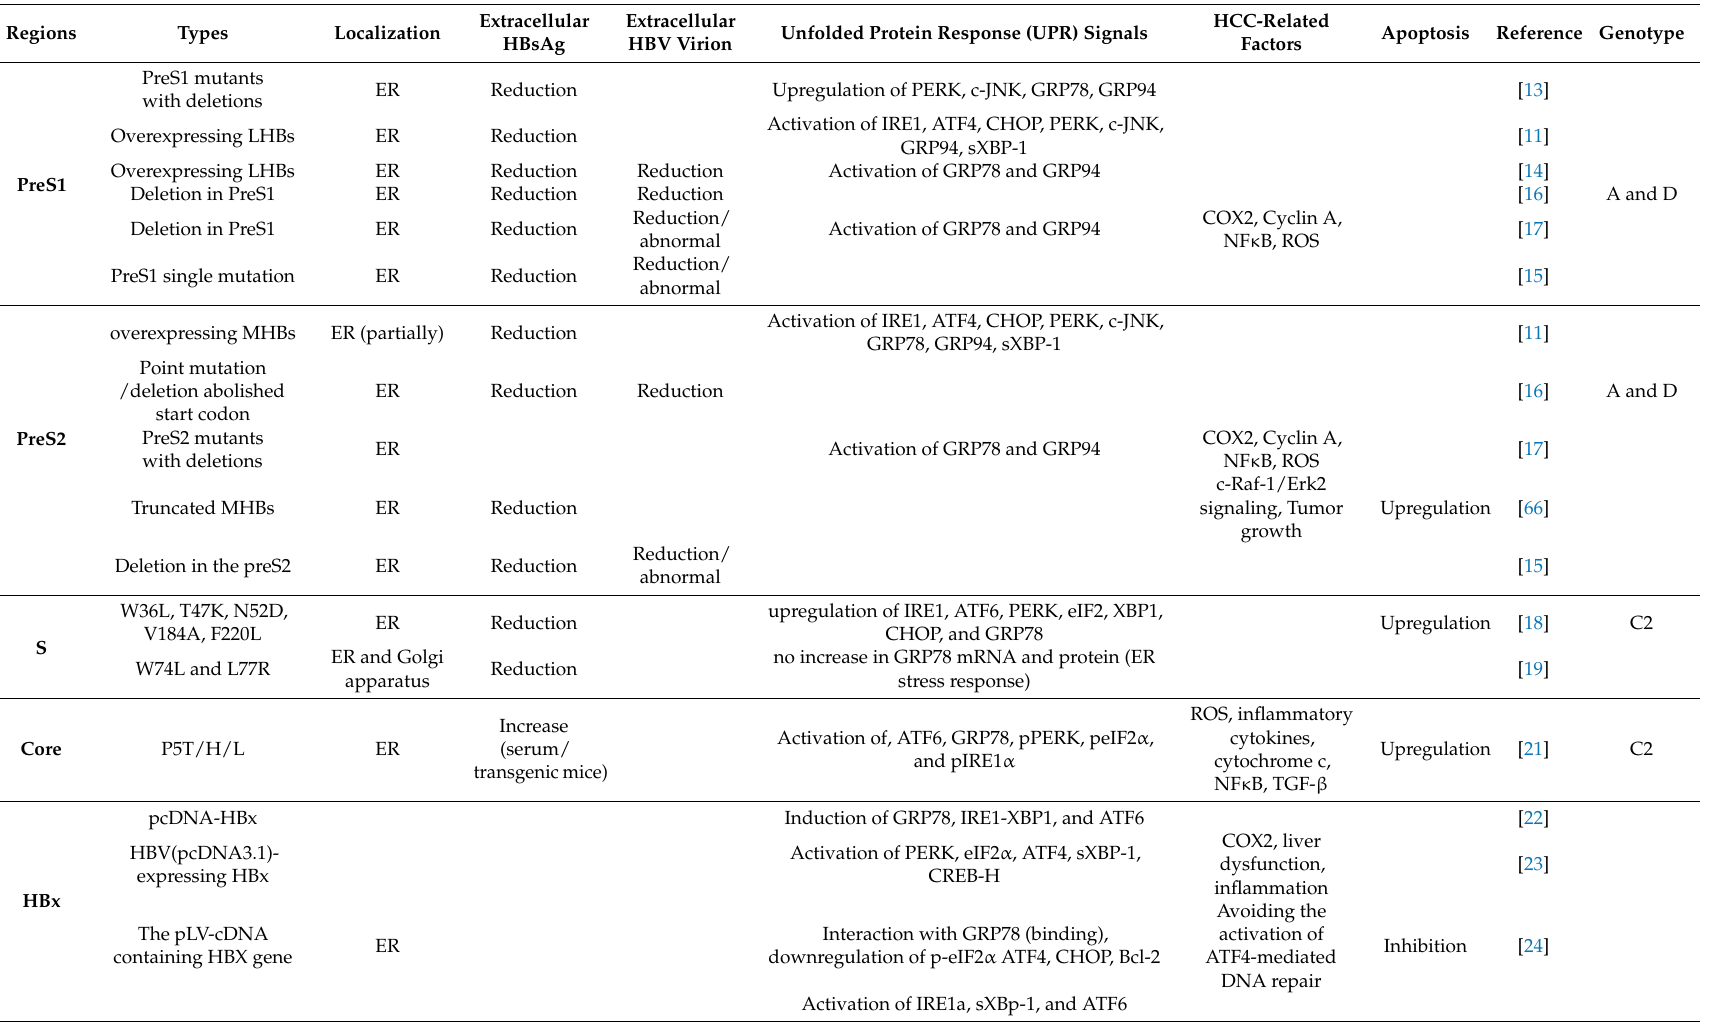
Table 1. Naturally occurring mutations in HBV leading to endoplasmic reticulum (ER) stress and their contribution to hepatocellular carcinoma (HCC).